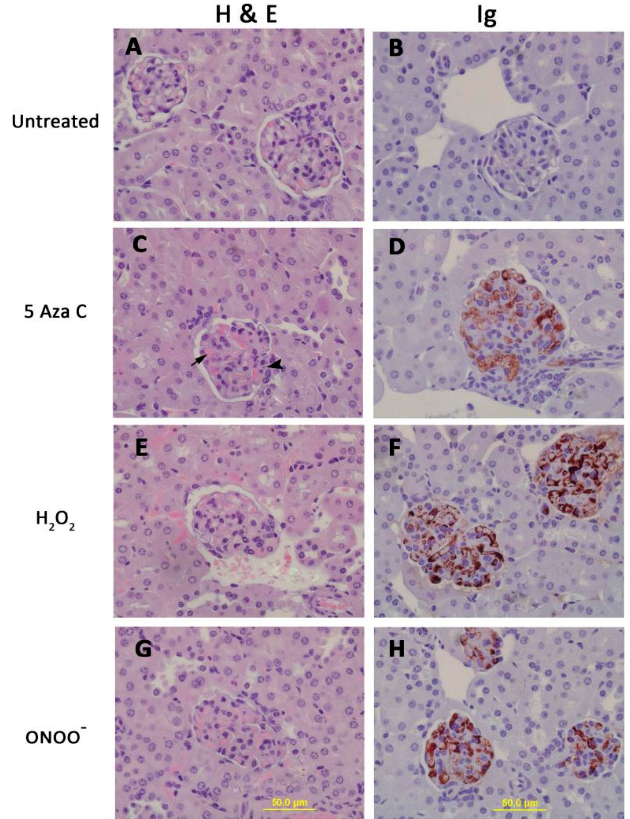
Figure 2. CD4 + T cells treated with 5-azaC, H 2 O 2 or ONOO − cause an immune